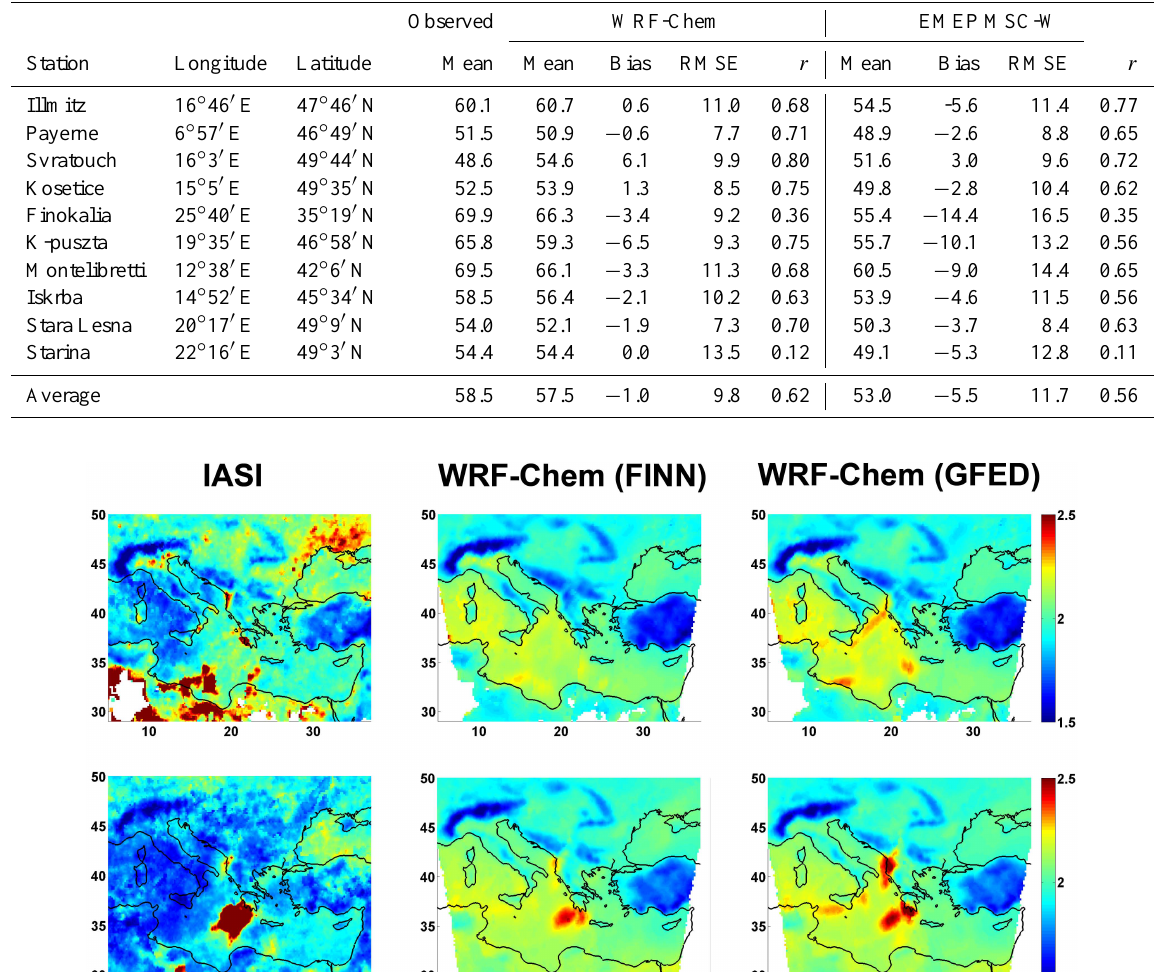
Table 4. Comparison between observed and modelled daily maximum O 3 mixing ratios (ppbv) for 10 stations (see http://ebas.nilu.no).